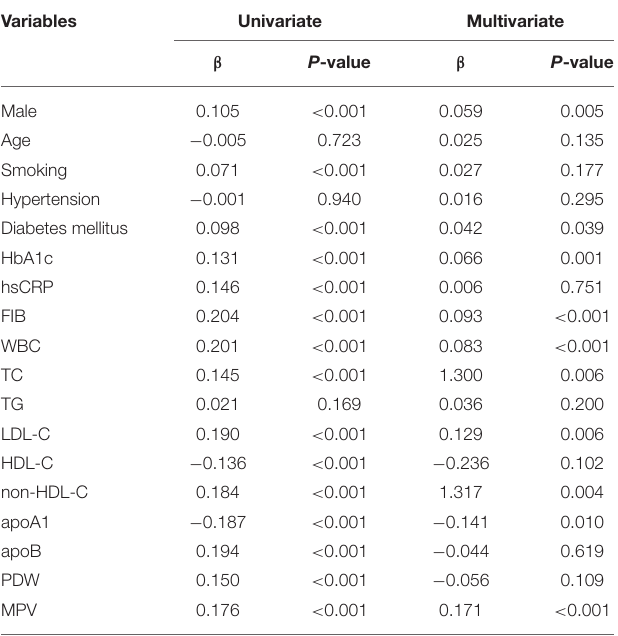
TABLE 4 | Association of MPV with GS (GS > 0, n = 4,425).